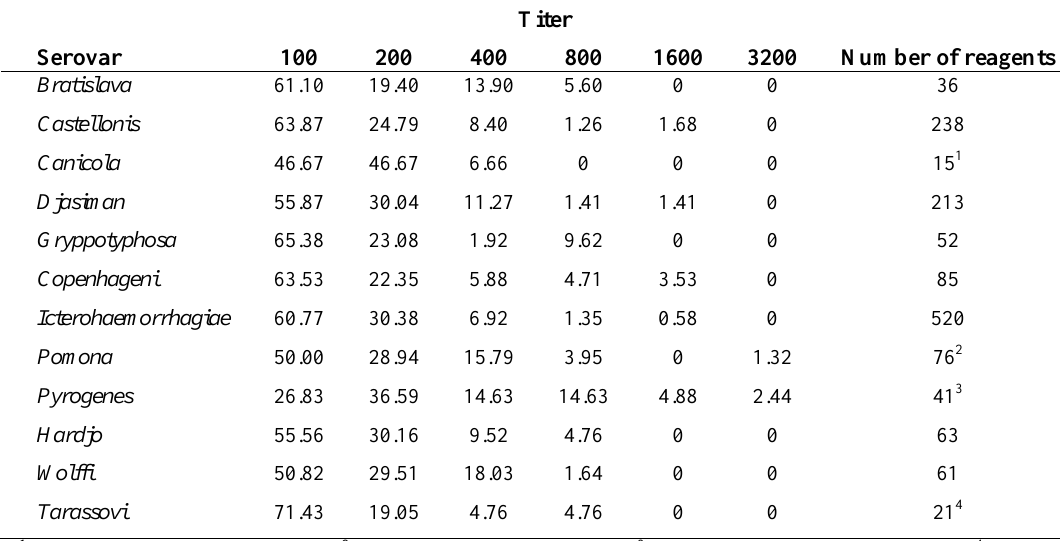
Table 1. Distribution of positive titers (%) of 1402 horses from Brazil, evaluated by Microscopic Agglutination Test (MAT) for twelve Leptospira serovars, Botucatu, 2003.